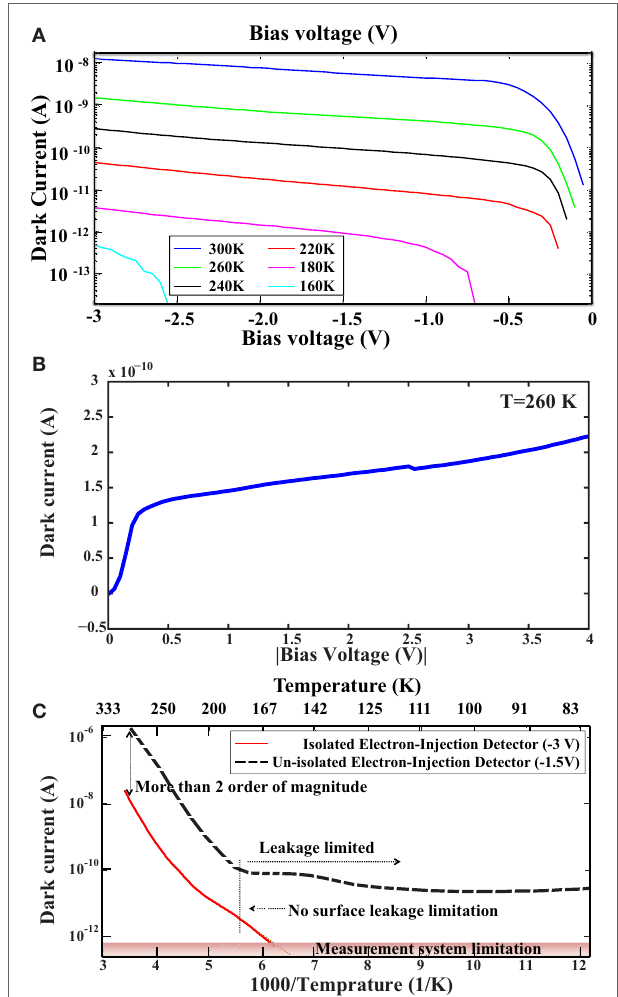
FiGURe 10 | (A) Logarithmic plot of dark current versus bias voltage at different temperatures. (B) Dark current versus bias characteristic at 260 K. Please note that a negative bias is applied to the injector with respect to the backside substrate and (B) shows the magnitude of bias voltage. (C) Arrhenius comparison of the dark current of an isolated electron-injection detector with 10 μ m injector and 30 μ m absorber diameter (at − 3 V bias) with our previously reported result of un-isolated devices with 10 μ m injector (at − 1.5 V bias). More than two orders of magnitude reduction in dark current is achieved. Furthermore, in the isolated detectors, no sign of temperature independent dark current was observed below 175 K, down to 160 K (Fathipour et al., 2013b, 2014b).